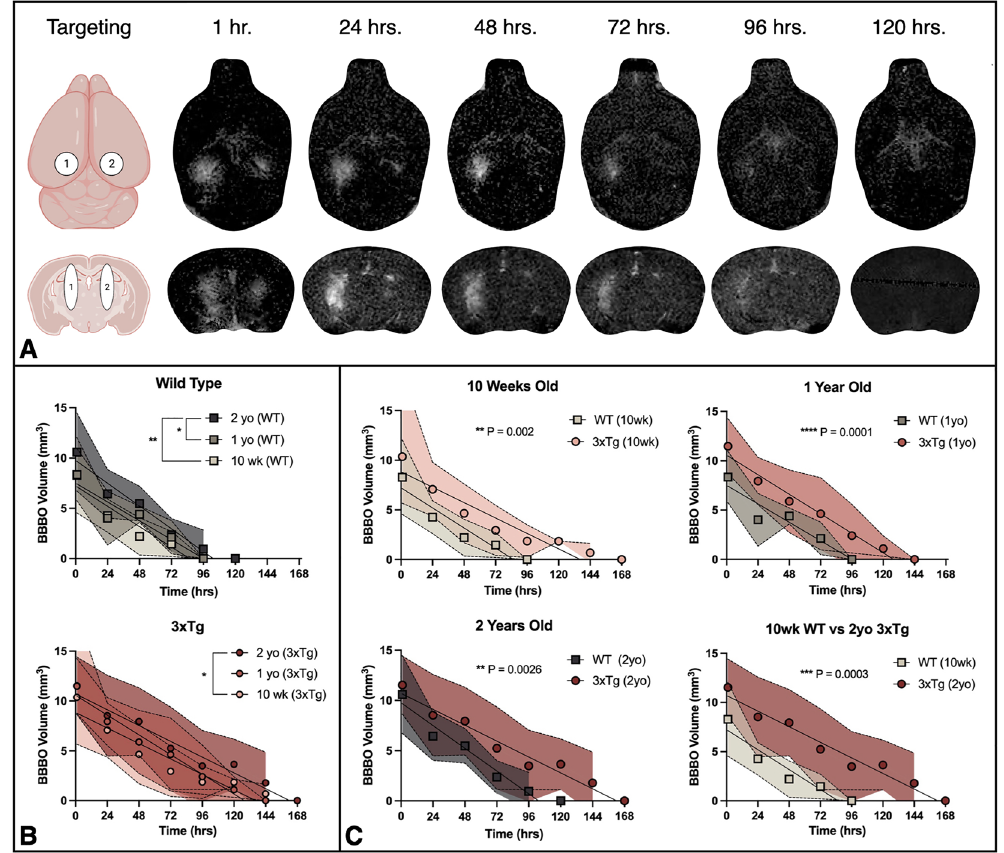
Figure 3. Linear regression of blood–brain barrier opening volume over time reveals increased fitted initial opening volume with age and AD. ( A ) BBBO targeting and representative MR axial and coronal images acquired at 24-h intervals after FUS-BBBO show the daily BBBO volume and progressive closing. (Elements created with BioRender.com) ( B ) Average BBBO volume and standard deviation is plotted as a function of time for WT and 3xTg cohorts ( B ) as well as for 10-week-old, one-year-old, and two-year-old cohorts ( C ). Linear regression analysis and statistical testing by ANCOVA was used to detect significant differences between fitted y-intercepts.